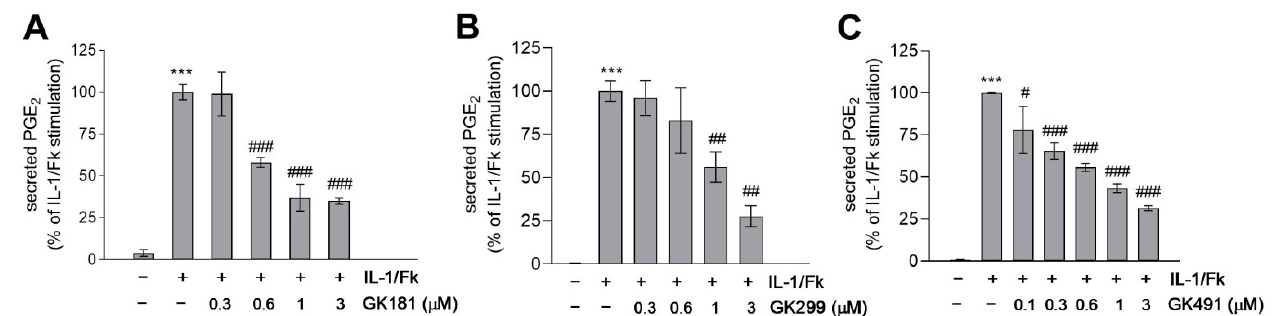
Figure 8. Effect of compounds ( A ) GK181, ( B ) GK299, and ( C ) GK491 on IL-1/Fk-stimulated PGE 2 formation in mesangial cells. Cells were pretreated for 20 min with the indicated concentrations of GK compounds and then stimulated for 24 h in the absence ( − ) or presence (+) of 1 nM interleukin 1 β (IL-1) plus 5 µ M forskolin (Fk). Supernatants were taken for PGE 2 quantification using an enzyme-linked immunoassay as described in the Methods section. Data are presented as % of maximal IL-1/Fk stimulation and are means S.D. ( n = 3). *** p < 0.001 considered statistically significant when compared to the unstimulated samples; # p < 0.05, ## p < 0.01, ### p < 0.001 compared to the IL-1/Fk-stimulated samples.